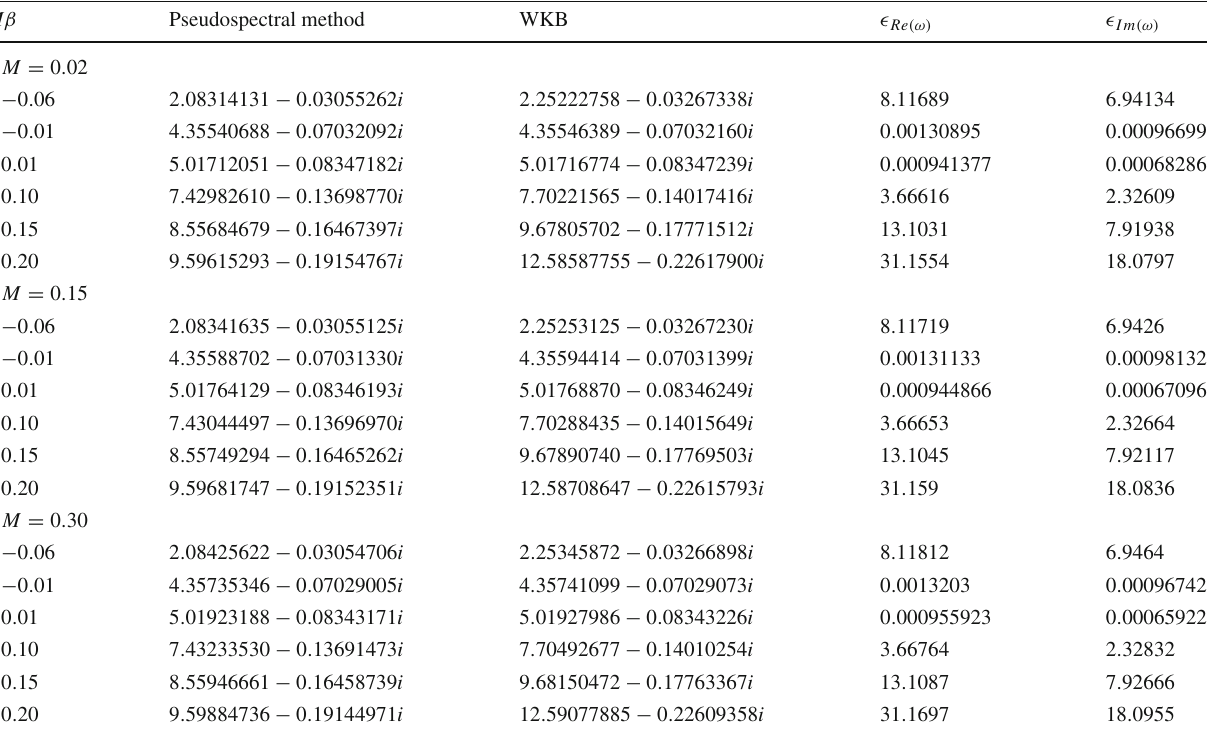
Table 2 Fundamental quasinormal frequencies ( n PS = 0) for massive scalar fields with (cid:5) = 30 in the background of black hole solution of f ( R ) gravity with M 2 (cid:6) = 0 . 04, and different values of M